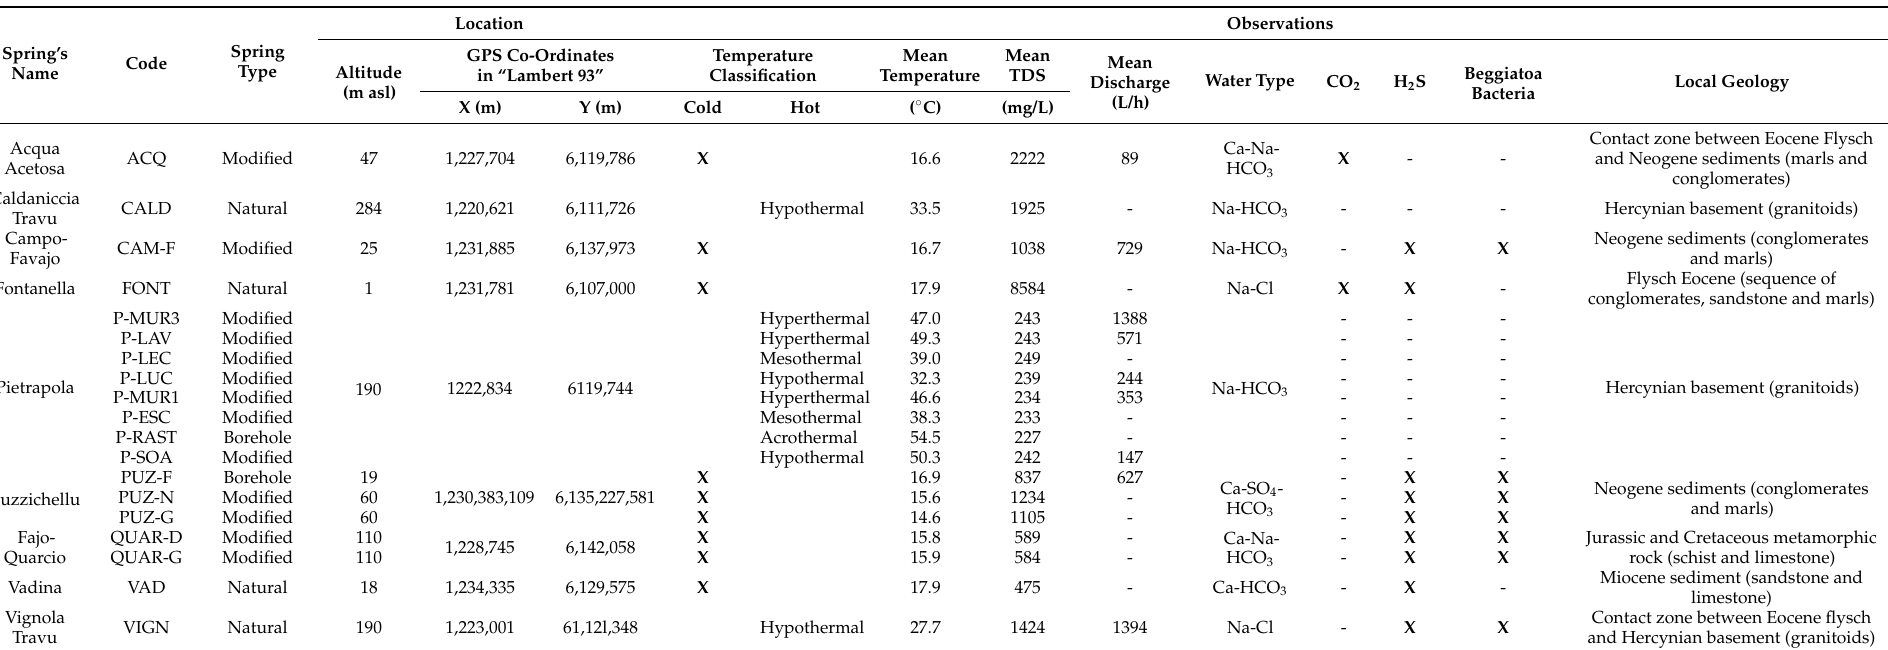
Table 1. Background information on sampling sites: spring codification, location and observations. Spring type is described as “Natural” for spring without equipment to channel water flows; “Modified” for springs with equipment to channel water flows; “Borehole”. (X) Presence, (-)